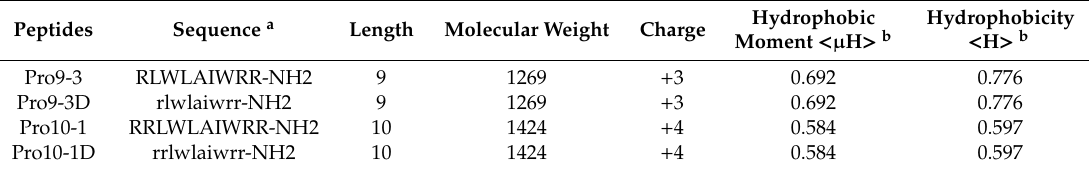
Table 1. Peptides and their physicochemical properties.